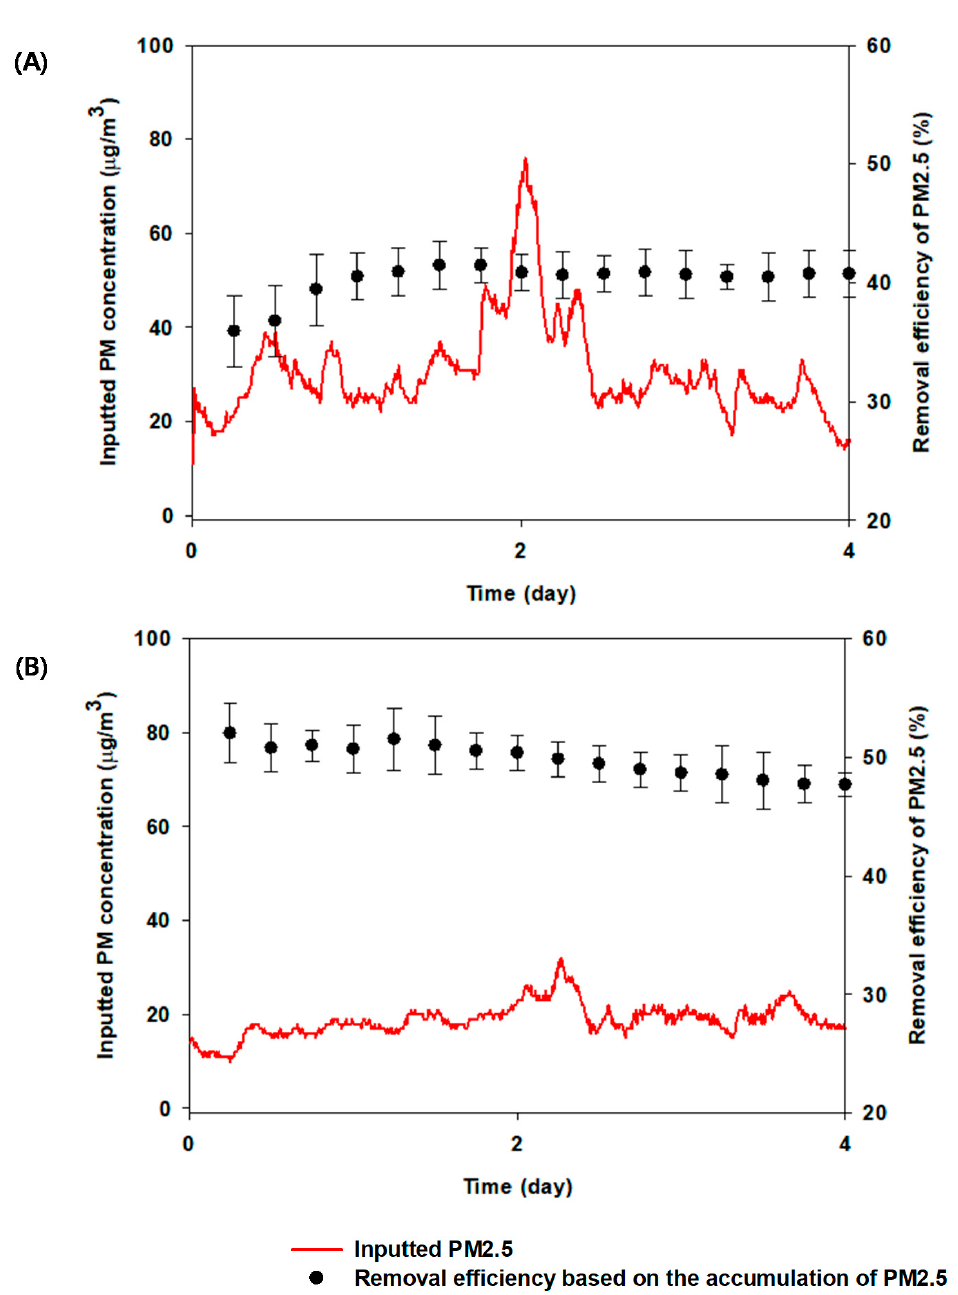
Figure 8. Removal efficiency of PM2.5 by the indoor plant-based biofilter system containing Hedera helix as different plant under CL (continuous light) with ( A ) drought and ( B ) water supply. The error bars represent standard deviation.